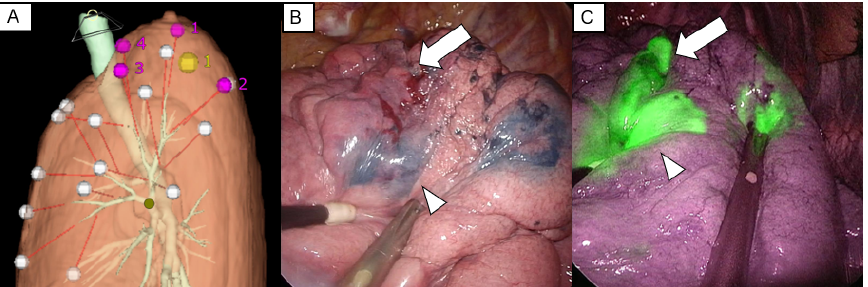
Figure 3. Virtual-assisted lung mapping using both indigo carmine and indocyanine green. ( A ) Four markings (pink circle) surrounding the nodule (yellow circle) are planned before virtual-assisted lung mapping using three-dimensional reconstruction of computed tomography data and virtual bronchoscopic images. ( B ) One marking with indigo carmine (arrowhead) is barely identifiable, and another marking (arrow) cannot be detected. ( C ) Indocyanine green can be easily identified using near-infrared thoracoscope.